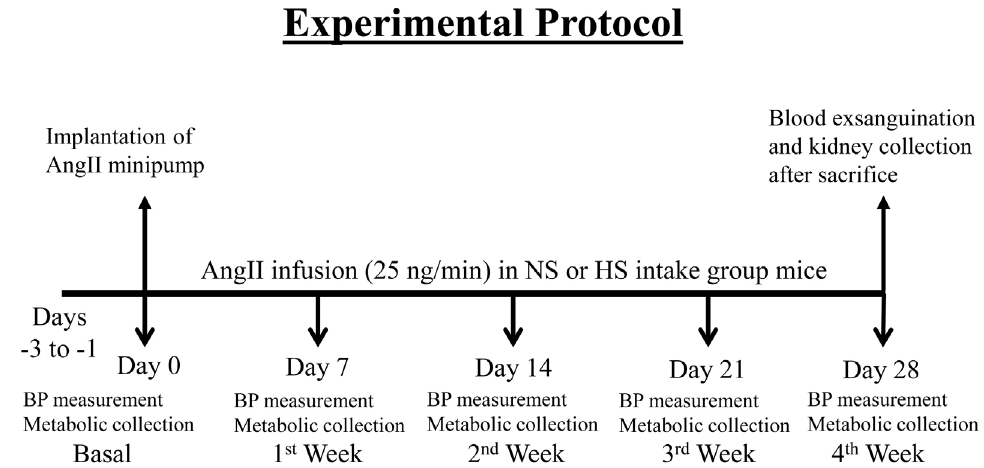
Figure 1. Experimental protocol for chronic studies with AngII infusion using minipump in mice given NS (NS; 0.3% NaCl) and HS (HS; 4% NaCl) containing diet BP monitoring in conscious